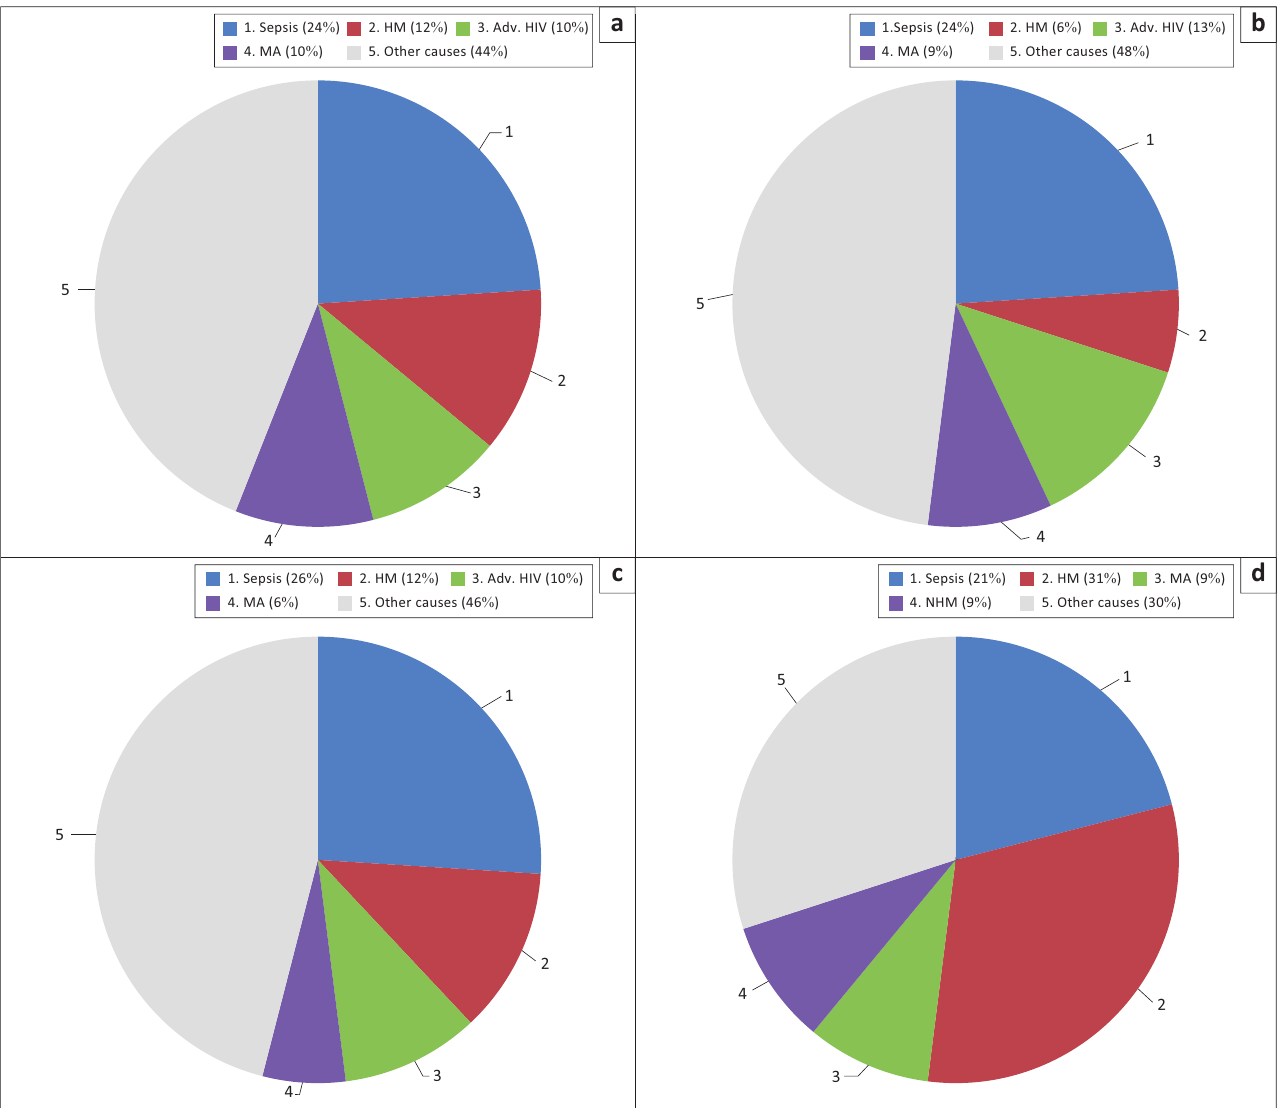
FIGURE 5: Most common causes of non-treatment-related pancytopenia among adult patients at Tygerberg Academic Hospital, Cape Town, South Africa, from January 2016 to December 2017. (a) All patients ( N = 507), (b) 18–39 years old ( n = 250), (c) 40–59 years old ( n = 172), (d) 60–89 years old ( n = 85). Adv. HIV, advanced HIV; HM, haematological malignancy; MA, megaloblastic anaemia; NHM, non-haematological